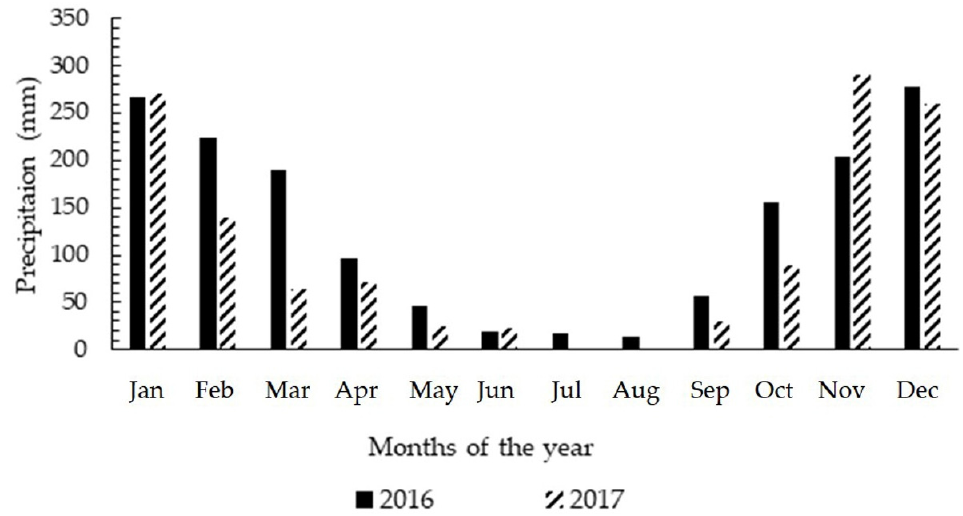
Figure 1. Monthly rainfall in 2016 and 2017 in Uberaba, MG. Brazil.